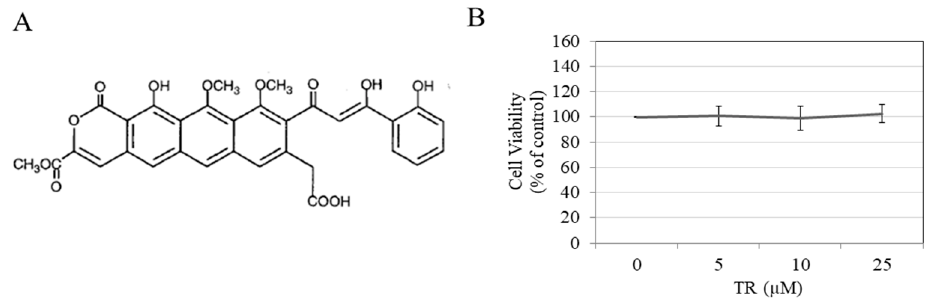
Figure 1. ( A ) Chemical structure of TR; ( B ) B16F10 cell viability in the presence of different concentrations of TR for 72 h duration assessed by MTS assay; Data is Mean ± SD of three independent